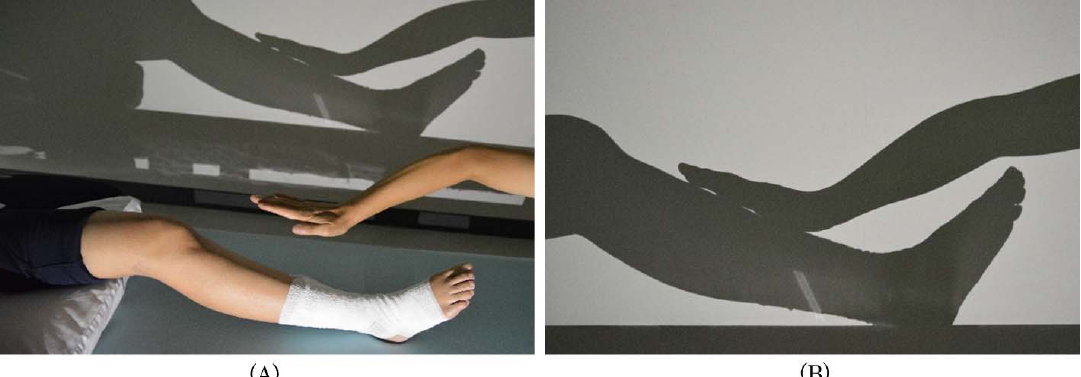
Figure 2. Intervention method using body shadows (first step). A body shadow is created on the